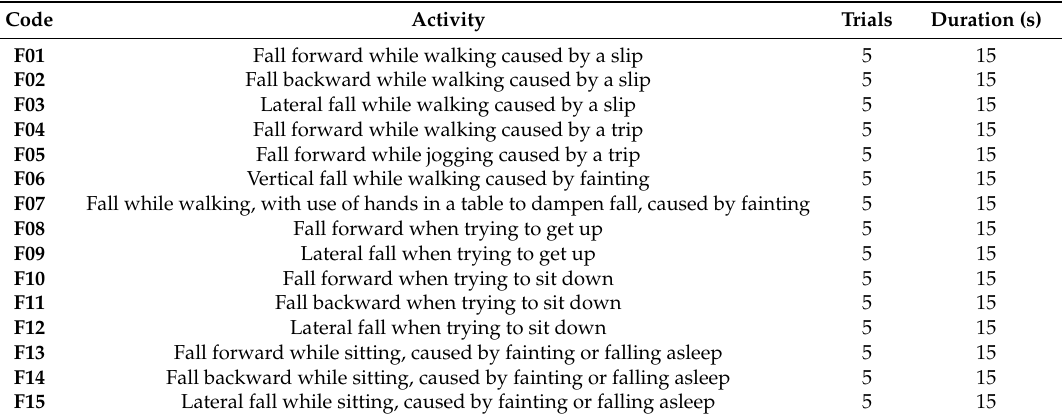
Table 2. Types of falls in SisFall dataset.